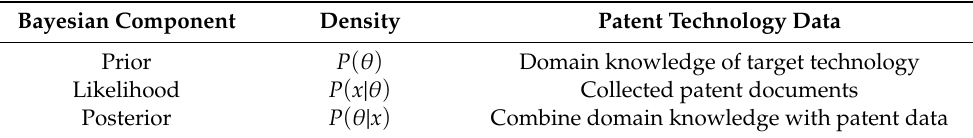
Table 1. Bayesian inference and patent technology